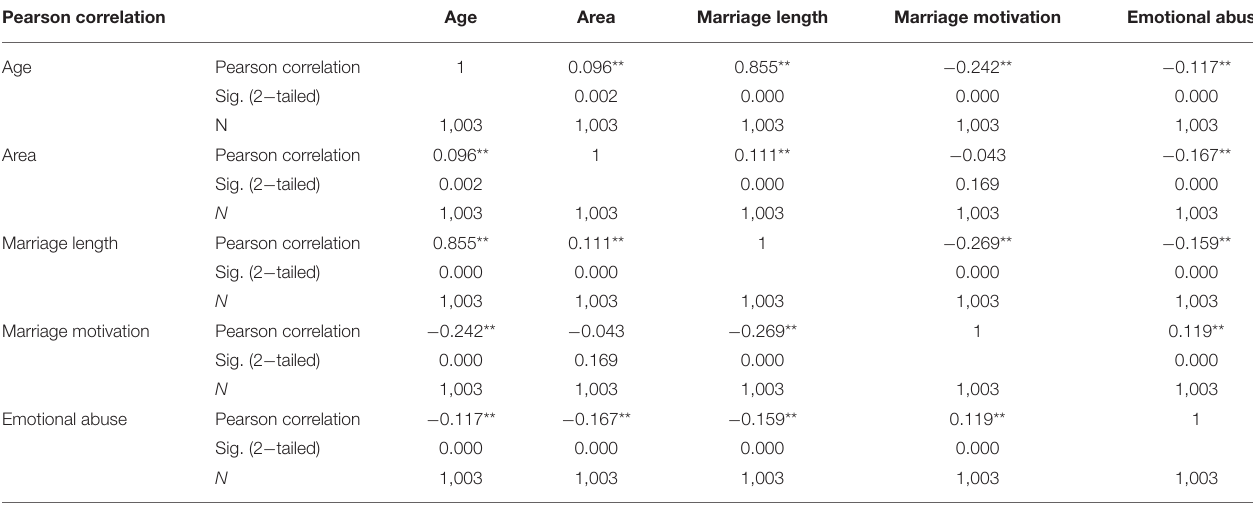
TABLE 5 | Correlation analysis. Pearson